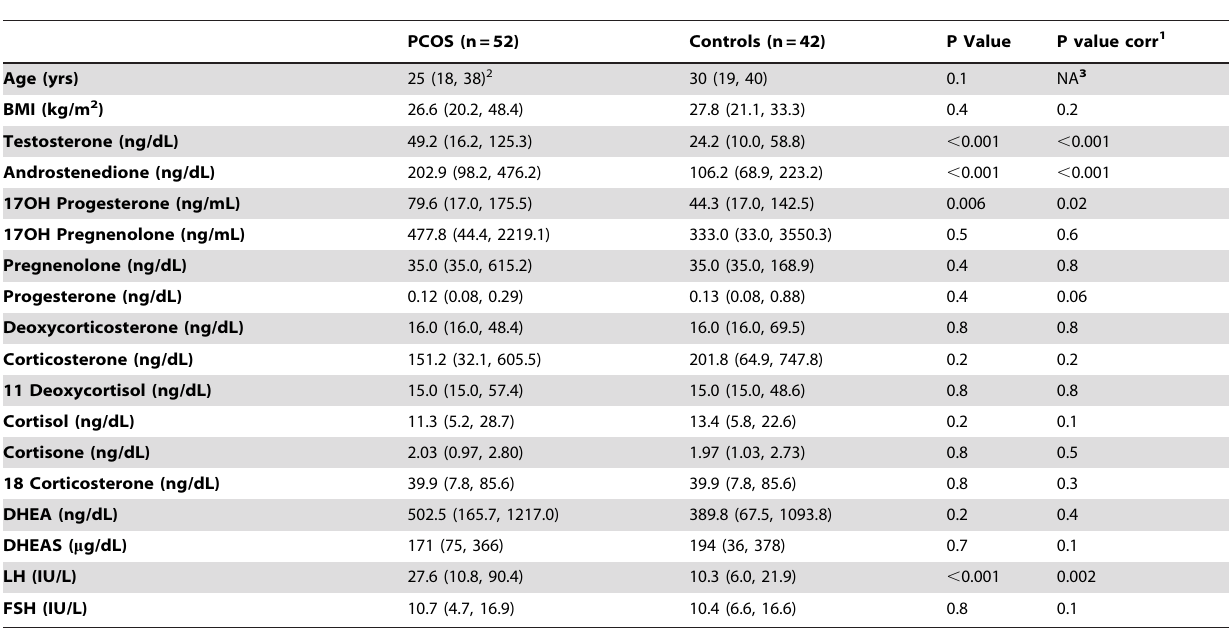
Table 1. Age, BMI and steroid concentrations in women with PCOS and controls in the follicular phase.